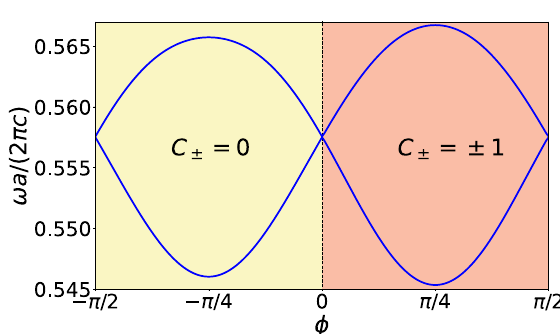
Figure 4. Effect of the perturbation in the band structure. Upper and lower edges of the bandgap as a function of φ , at the Ŵ point, with R doubly degenerate resulting in a Dirac cone. For